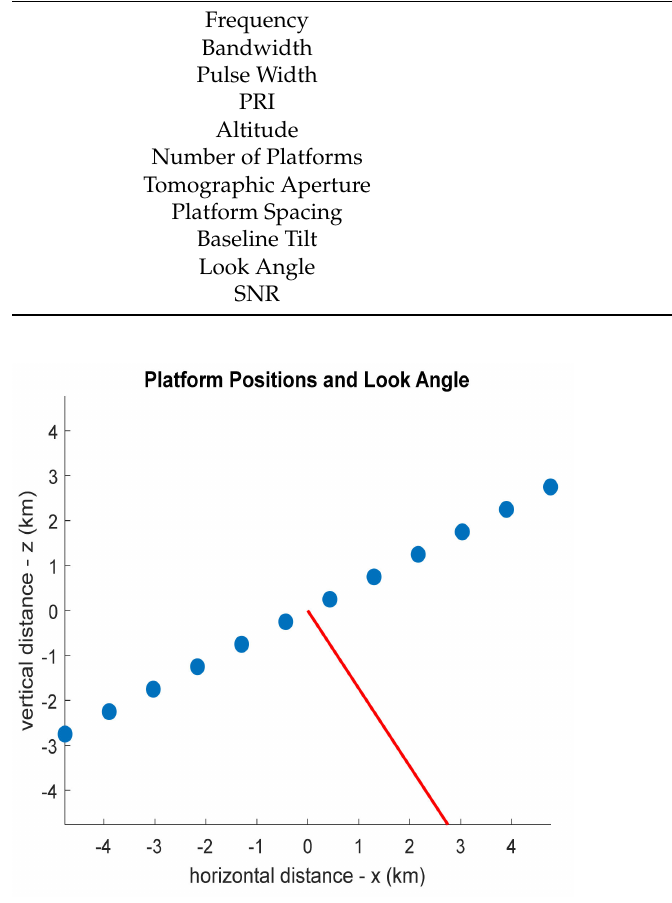
Figure 21. The observation geometry for Example 1. Blue dots represent the platform locations and the red line represents the look